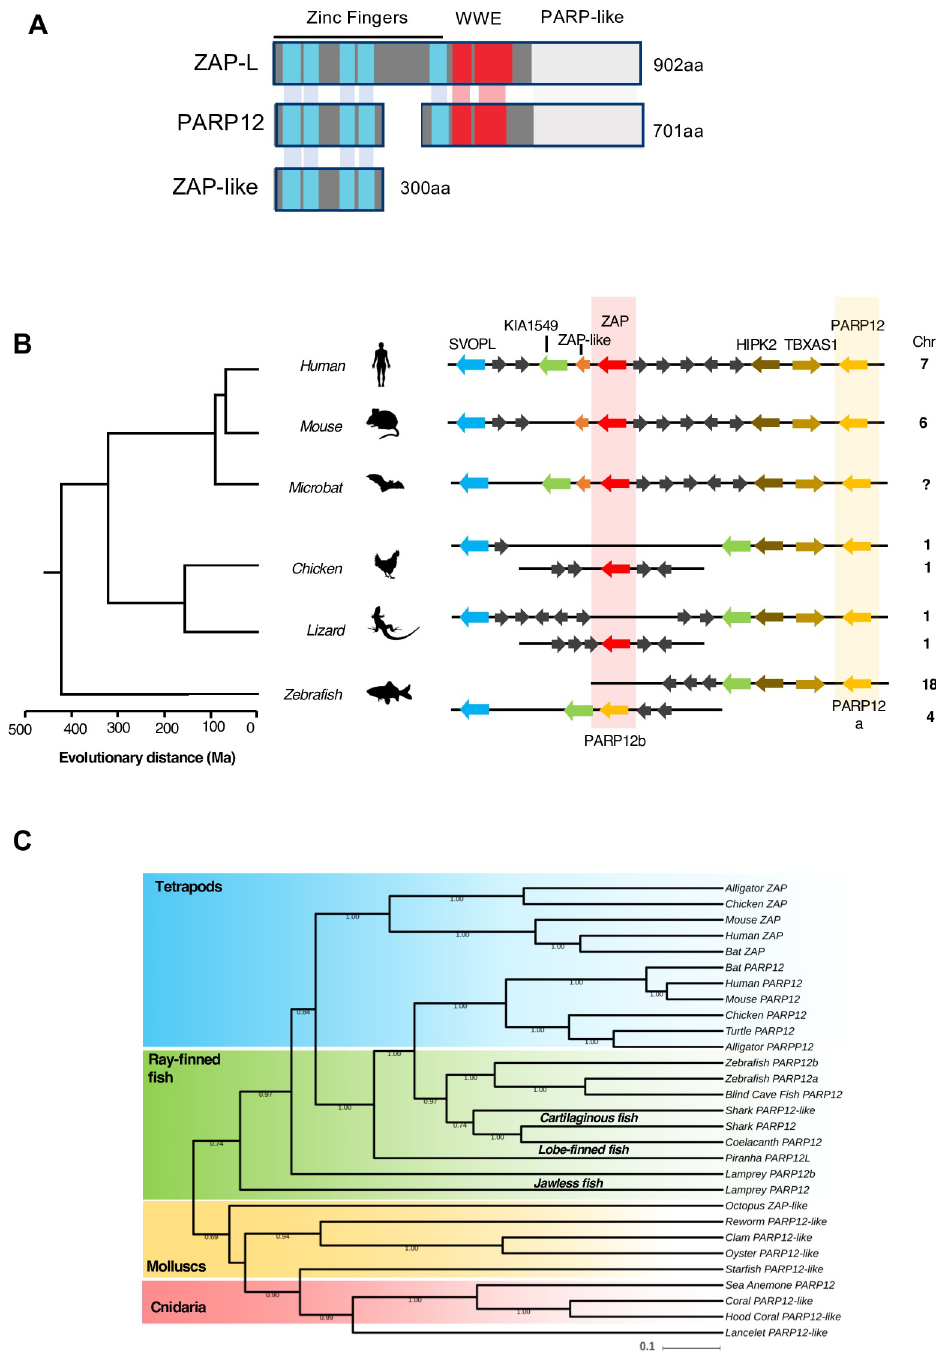
Fig 1. ZAP and PARP12 share a common ancestor. (A) Schematic representation of the domain organization of human ZAP and its paralogues PARP12 and ZAP-like. (B) Diagrams of the organization of PARP12 (in yellow) and ZAP (in red) loci in vertebrate genomes generated using multiple genome browsers (NCBI, Ensembl, Genomicus). Evolutionary distance of the indicated species (presented in million years, Ma) is based on [36]. Chr, chromosome number. (C) Maximum likelihood tree (midpoint rooted) depicting phylogenetic relationships among PARP12- and ZAP -related genes in vertebrate and invertebrate species, generated with BEAST and 1000 bootstrap replicates. Shaded areas loosely clustered sequences from related species in the superclass Tetrapoda (in blue), clade Actinopterygii (Ray- finned fish, in green), the phylum Mollusca (molluscs, in yellow) and the phylum Cnidaria (in red).